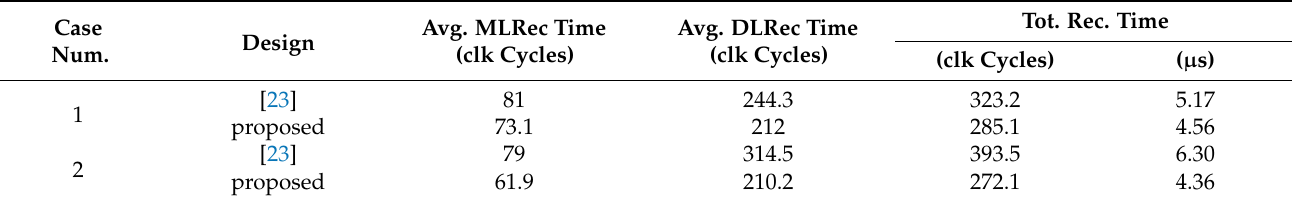
Table 2. Evaluation of recovery